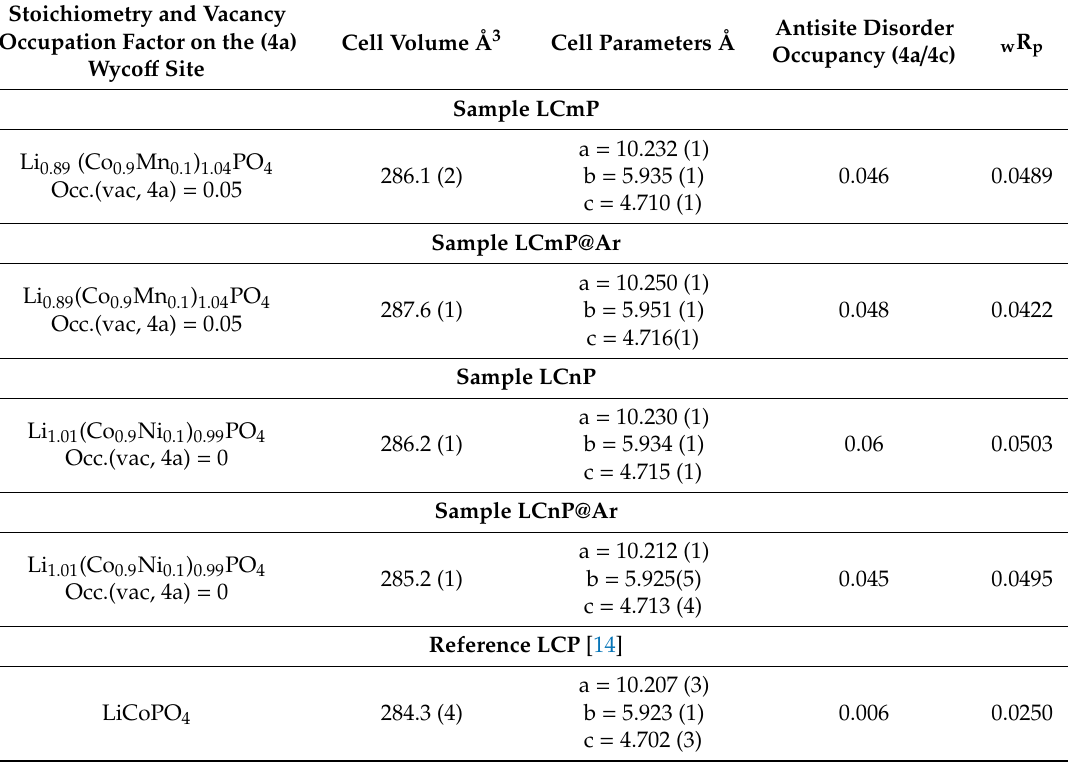
Table 2. Rietveld Refinement results for all samples. Errors on the last digit of the cell volume are reported in parenthesis (Occ. stands for occupancy factor, vac stands for unoccupied / vacant sites). Stoichiometry and